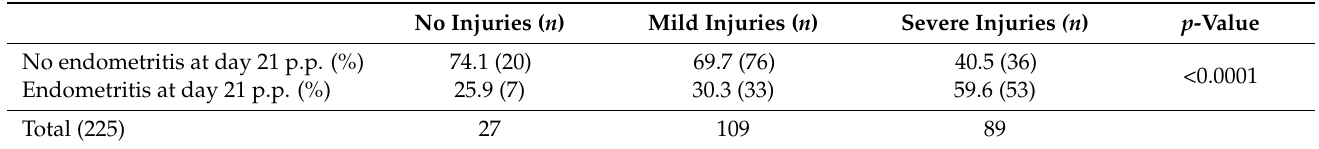
Table 5. Association between injuries of the soft birth canal (no injuries, mild injuries: maximum injuries of degree 1, severe injuries: injuries of degree 2, or combinations of no injuries or injuries of degree 1 with injuries of degree 2) and the occurrence of endometritis at day 21 p.p. No Injuries ( n ) Mild Injuries ( n ) Severe Injuries (n ) p